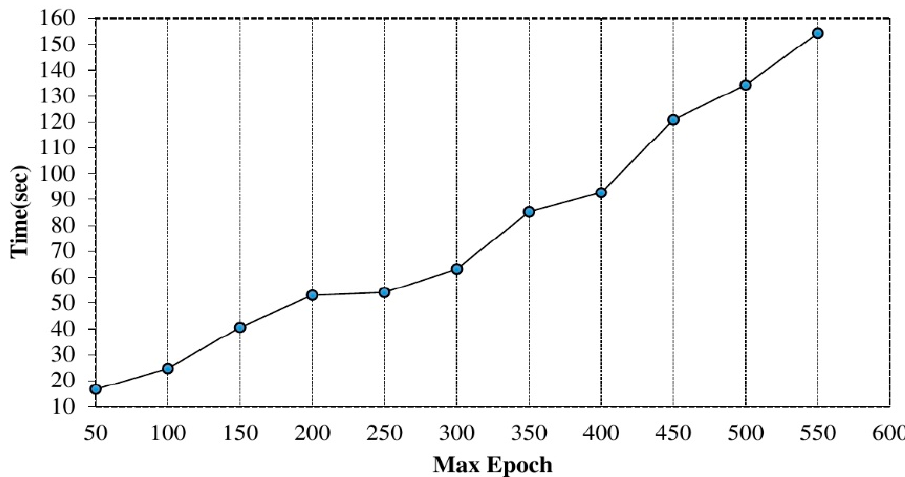
Figure 7. Computation time on increasing the max epoch.